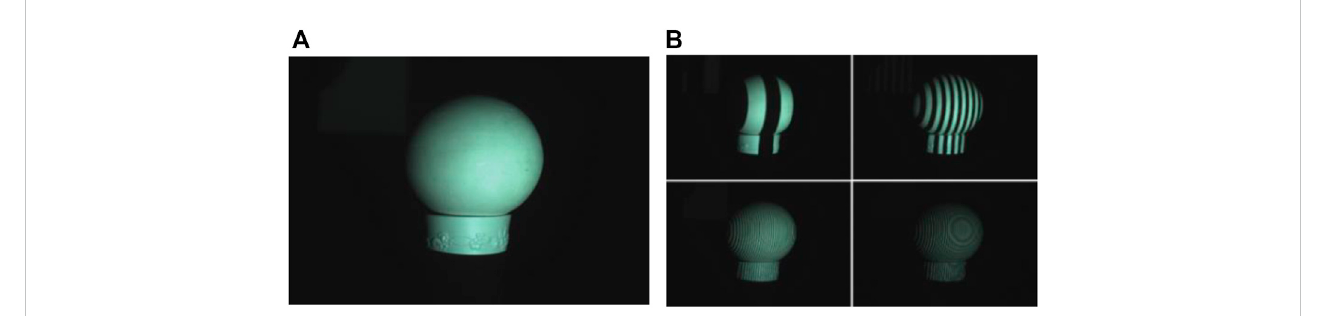
FIGURE 10 The measured sphere and its coding diagram. (A) Measured sphere; and (B) Encoding pattern.